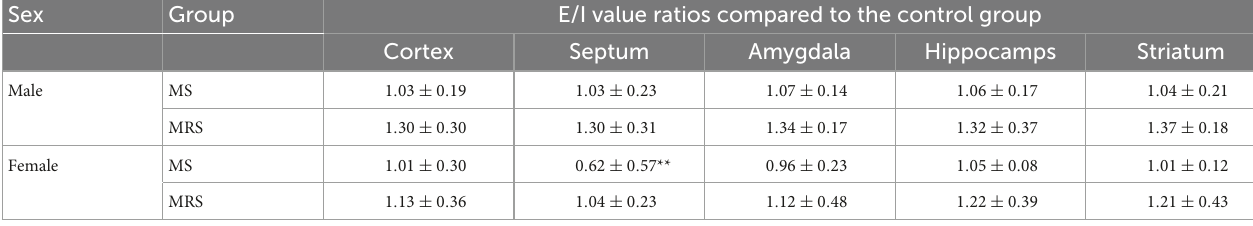
TABLE 3 The rate of change in E/I balance compared to the control group. Group E/I value ratios compared to the control